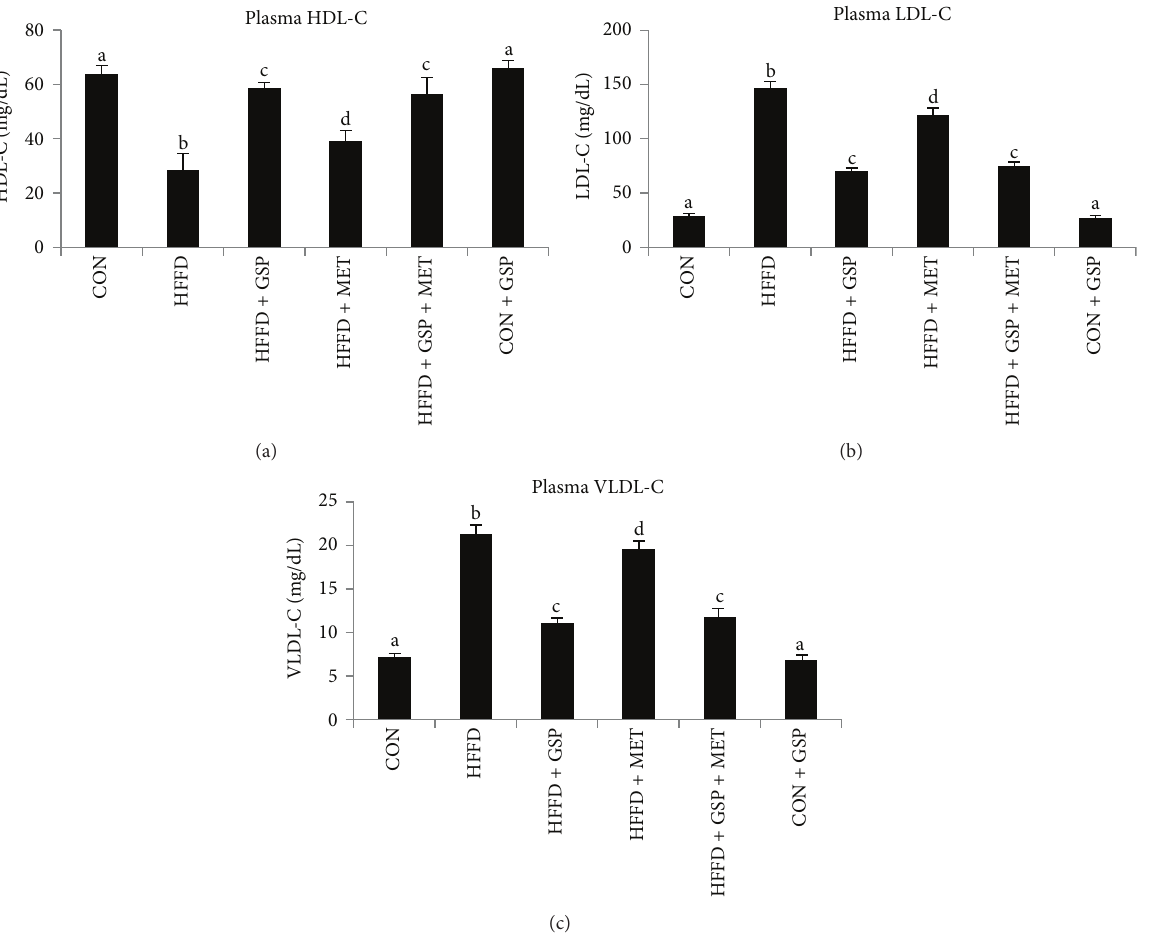
Figure 4: Effect of GSP and MET on levels of HDL-C (a), LDL-C (b), and VLDL-C (c) in liver of experimental animals. Data are expressed as means ± S.D. of 6 rats from each group. Statistical significance between the groups, denoted by different alphabets, was determined by one-way ANOVA of significance set at 𝑃 < 0.05